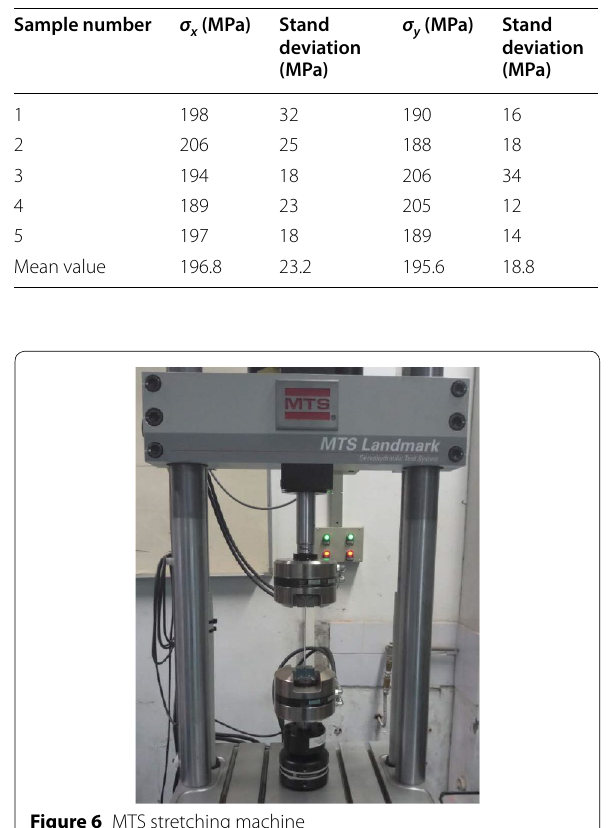
Table 5 Sample 1-5 surface residual stress